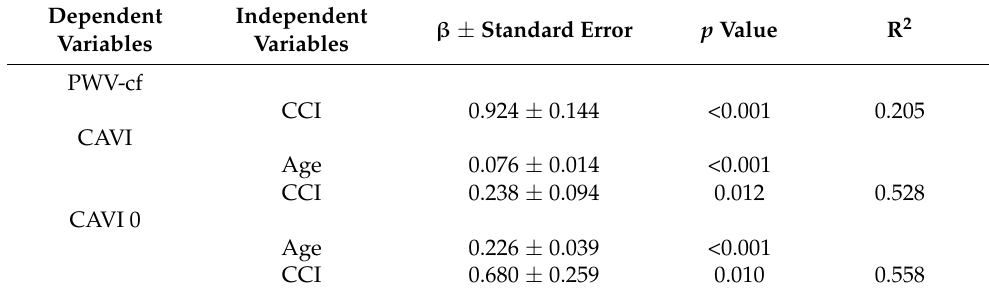
Table 3. Stepwise regression analysis, considering PWV-cf, CAVI, and CAVI 0 respectively as depen- dent variables, and age, glomerular filtration rate, mean arterial pressure, Charlson Comorbidity Index, LDL-Cholesterol and Triglycerides as independent